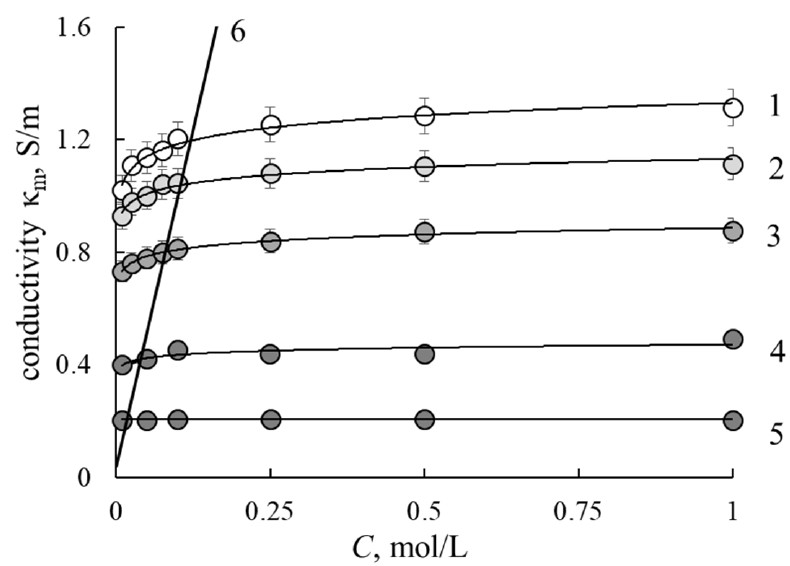
Figure 2. Conductivity concentration dependencies for investigated membranes with different portions of inert polymer: 1—M0, 2—M10, 3—M20, 4—M30, 5—M40, 6—NaCl solution.